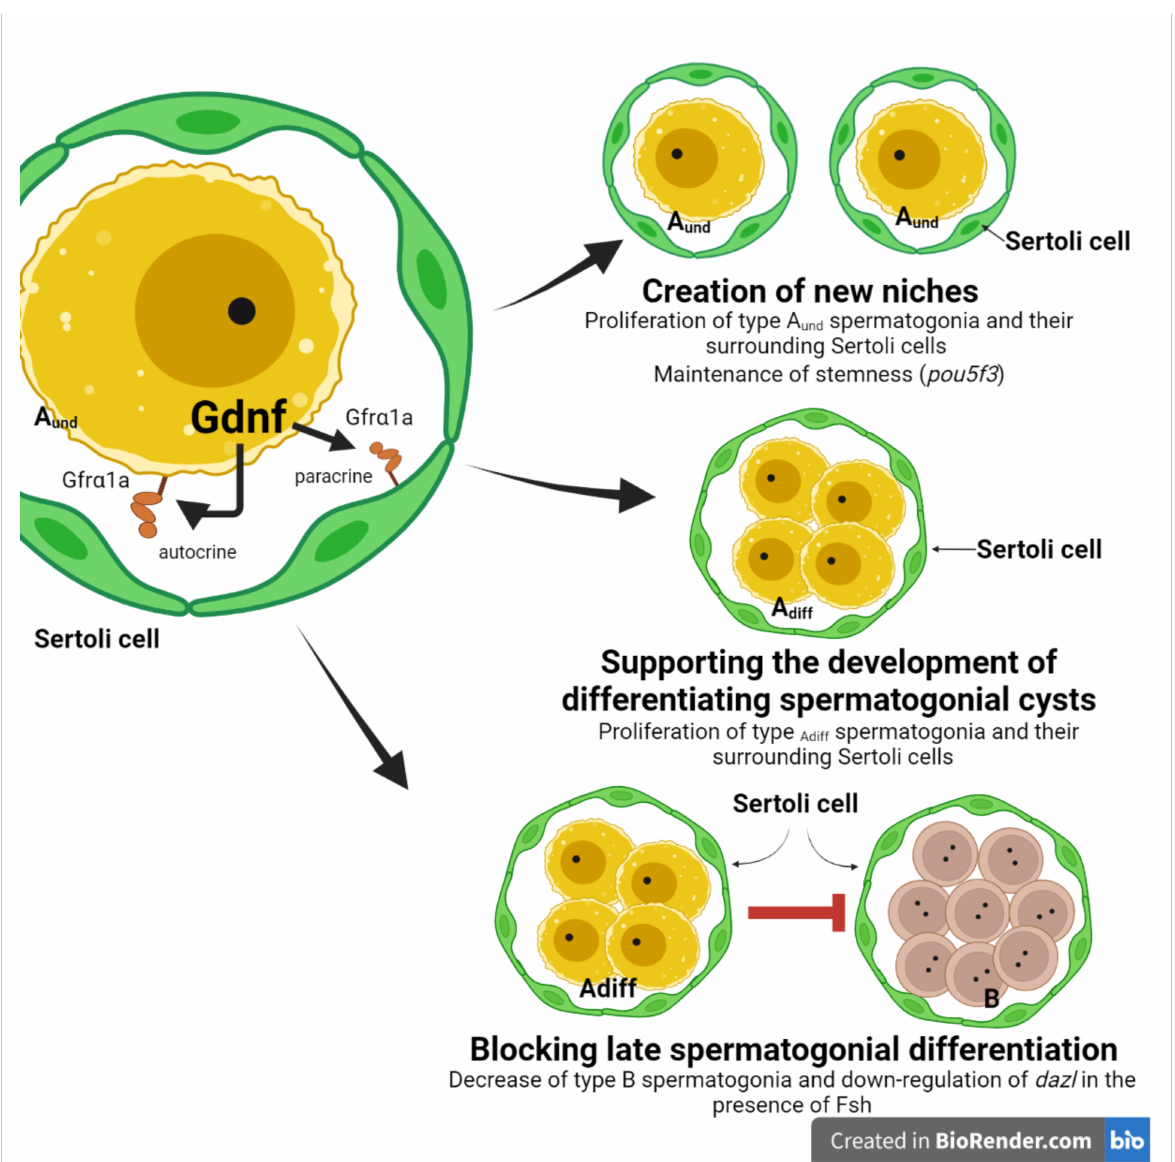
Figure 10. Summary of the effects of Gdnf in the zebrafish spermatogonial niche. Gdnf is a germ cell growth factor which acts on type A spermatogonia and their surrounding Sertoli cells in autocrine- and paracrine-dependent manners, respectively. The Gdnf receptor, named Gfr α 1a, is expressed in type A spermatogonia (early spermatogonia, with higher expression in types A und and A diff ) and Sertoli cells. The main actions of Gdnf are: (1) the creation of new available niches; (2) support of the development of early differentiating spermatogonial cysts; and (3) blocking of late spermatogonial differentiation.